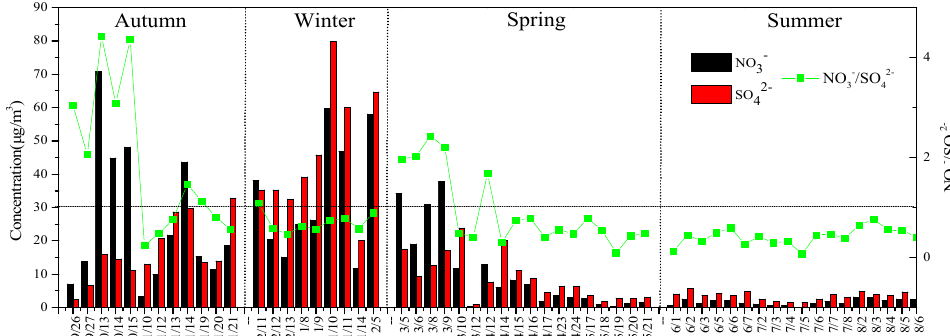
− − /SO 42 − daily and seasonal 42 − , NO , and NO 3 3